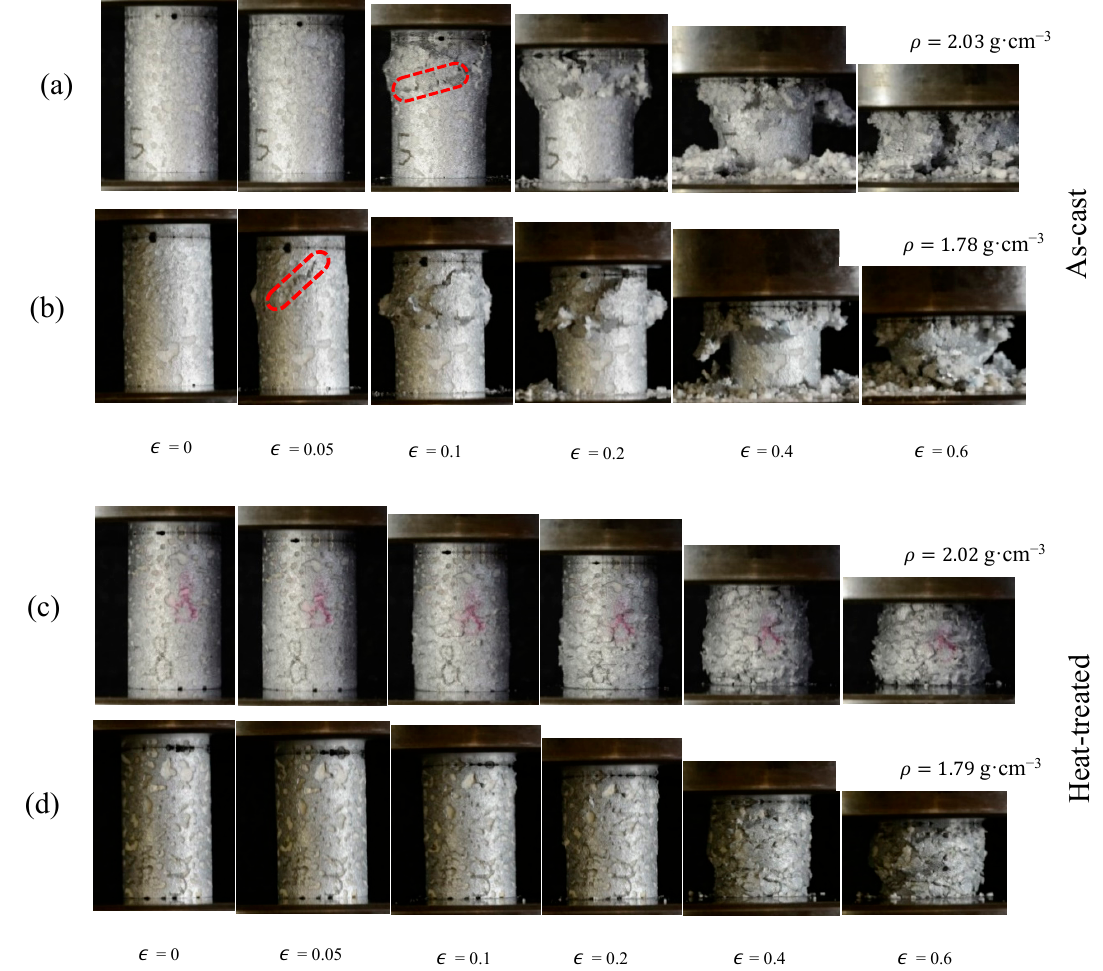
Figure 9. Deformation mechanism of ( a , b ) as-cast foams with densities of 2.03 and 1.78 g · cm − 3 respectively. ( c , d ) heat-treated foams with densities of 2.02 and 1.79 g · cm − 3 respectively.